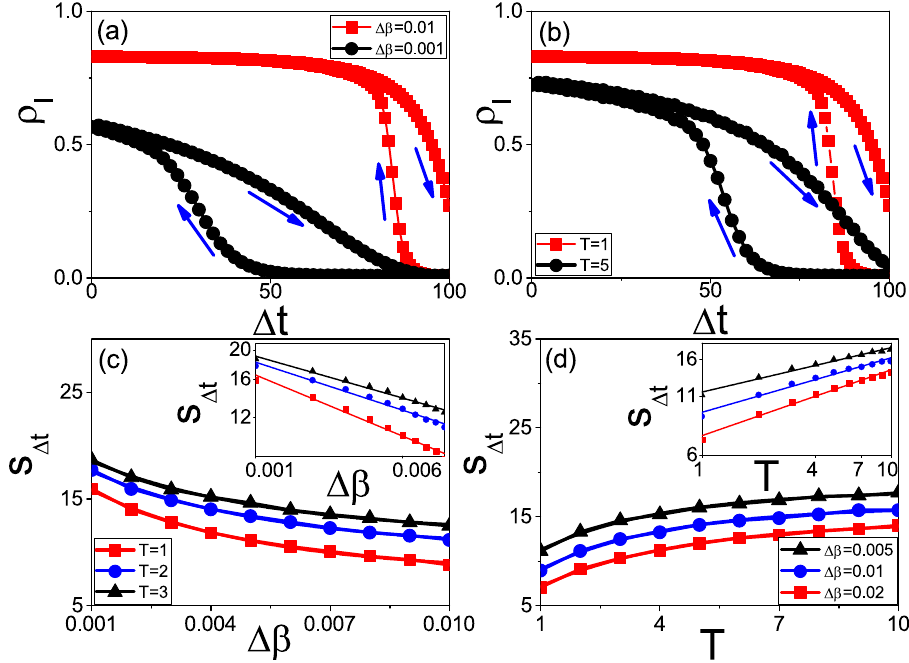
Figure 2. Hysteresis loops in state space where the arrows denote the evolutionary directions. ( a ) ρ I versus Δ t for fixed T = 1 where the curves with “squares” and “circles” represent the cases of Δ β = 0.01 and 0.001, respectively. ( b ) ρ I versus Δ t for fixed Δ β = 0.01 where the curves with “squares” and “circles” represent the cases of T = 1 and 5, respectively. ( c ) S Δ t versus Δ β where the curves with “squares”, “circles” and “triangles” represent the cases of T = 1, 2 and 3, respectively. The inset shows the log-log plot. ( d ) S Δ t versus T where the curves with “squares”, “circles” and “triangles” represent the cases of Δ β = 0.02, 0.01 and 0.005, respectively. The inset shows the log-log plot.